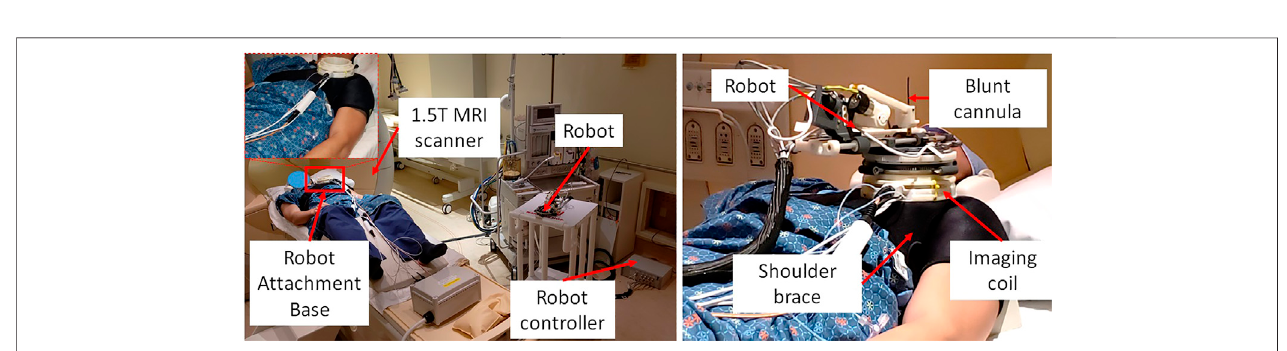
FIGURE 6 | System setup for one of the volunteer study showing (left) placement of system components in an interventional MRI suite and (right) robot attached on the shoulder of the volunteer using a shoulder brace.